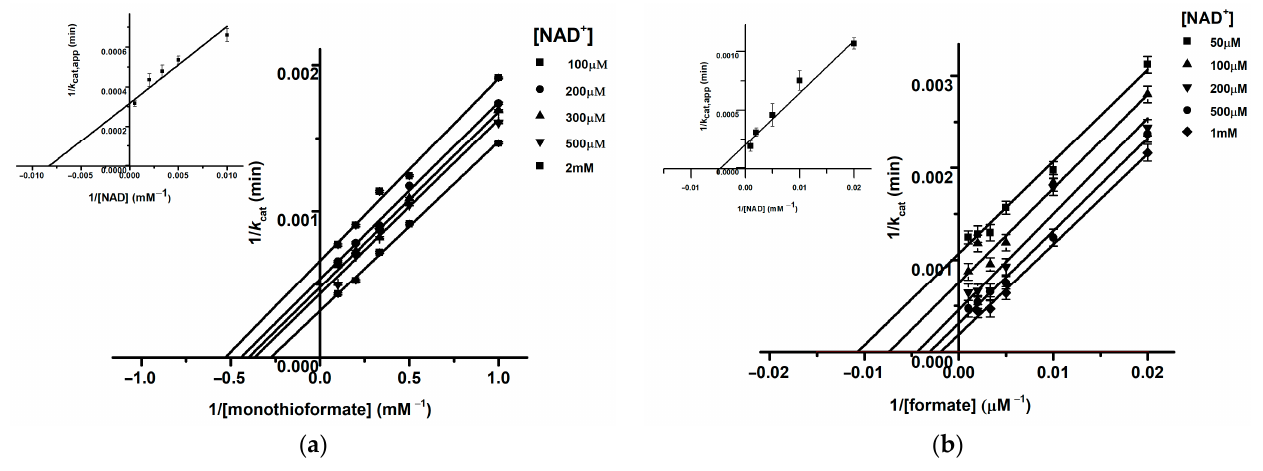
Figure 3. ( a ). Bisubstrate kinetics of the monothioformate oxidation reaction with NAD + as electron acceptor. Lineweaver–Burk plot of k cat using 7 nM FDH with varying thioformate concentrations of 0.5–20 mM and constant NAD + concentrations of 100 µ M, 200 µ M, 300 µ M, 500 µ M, and 1 mM measured in 100 mM Tris-HCl, pH 9, at room temperature). Inset: the K i value was obtained from the secondary plot of the apparent 1/V max of the Linewaever–Burk plot. The data represent the mean values of three independent measurements ( ± standard deviation). ( b ) Bisubstrate kinetics of the formate oxidation reaction with NAD + as electron acceptor. Lineweaver–Burk plot of k cat using 7 nM FDH with varying formate concentrations of 0.5–20 mM and constant NAD + concentrations of 500 µ M, 100 µ M, 200 µ M, 500 µ M, and 1 mM measured in 100 mM Tris-HCl, pH 9, at room temperature. Inset: the K m and k cat values were obtained from the secondary plot of the apparent 1/ k cat app intercepts of the Lineweaver–Burk plot. The data represent the mean values of three independent measurements ( ± standard deviation). In contrast, dithioformate was not accepted as a substrate by R. capsulatus FDH and acted instead as a competitive inhibitor (Figure 4), with a K i of 7.5 mM calculated from the secondary plot.